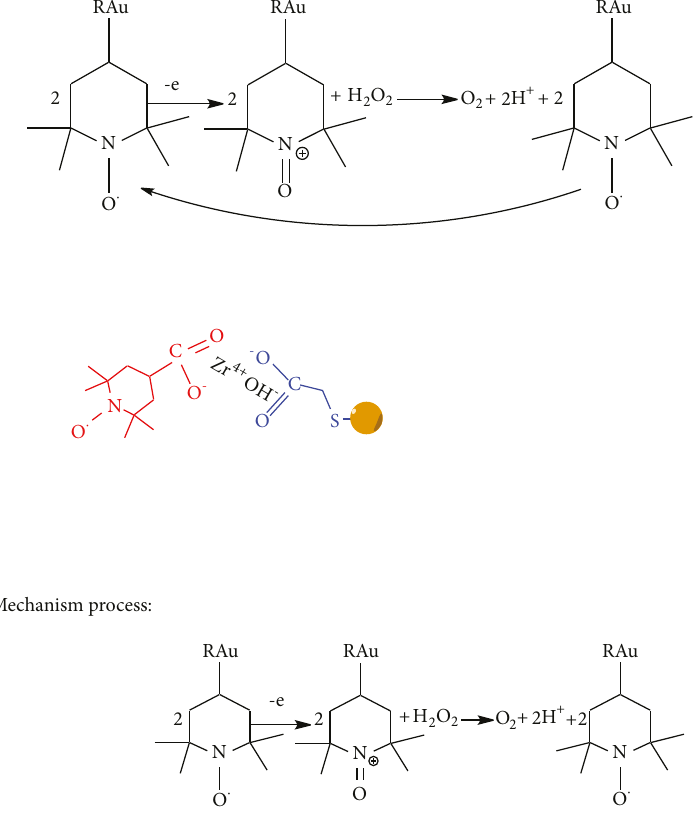
Scheme 1: Equilibrium of single electron between TEMPO-np-AuNPs and H 2 O 2